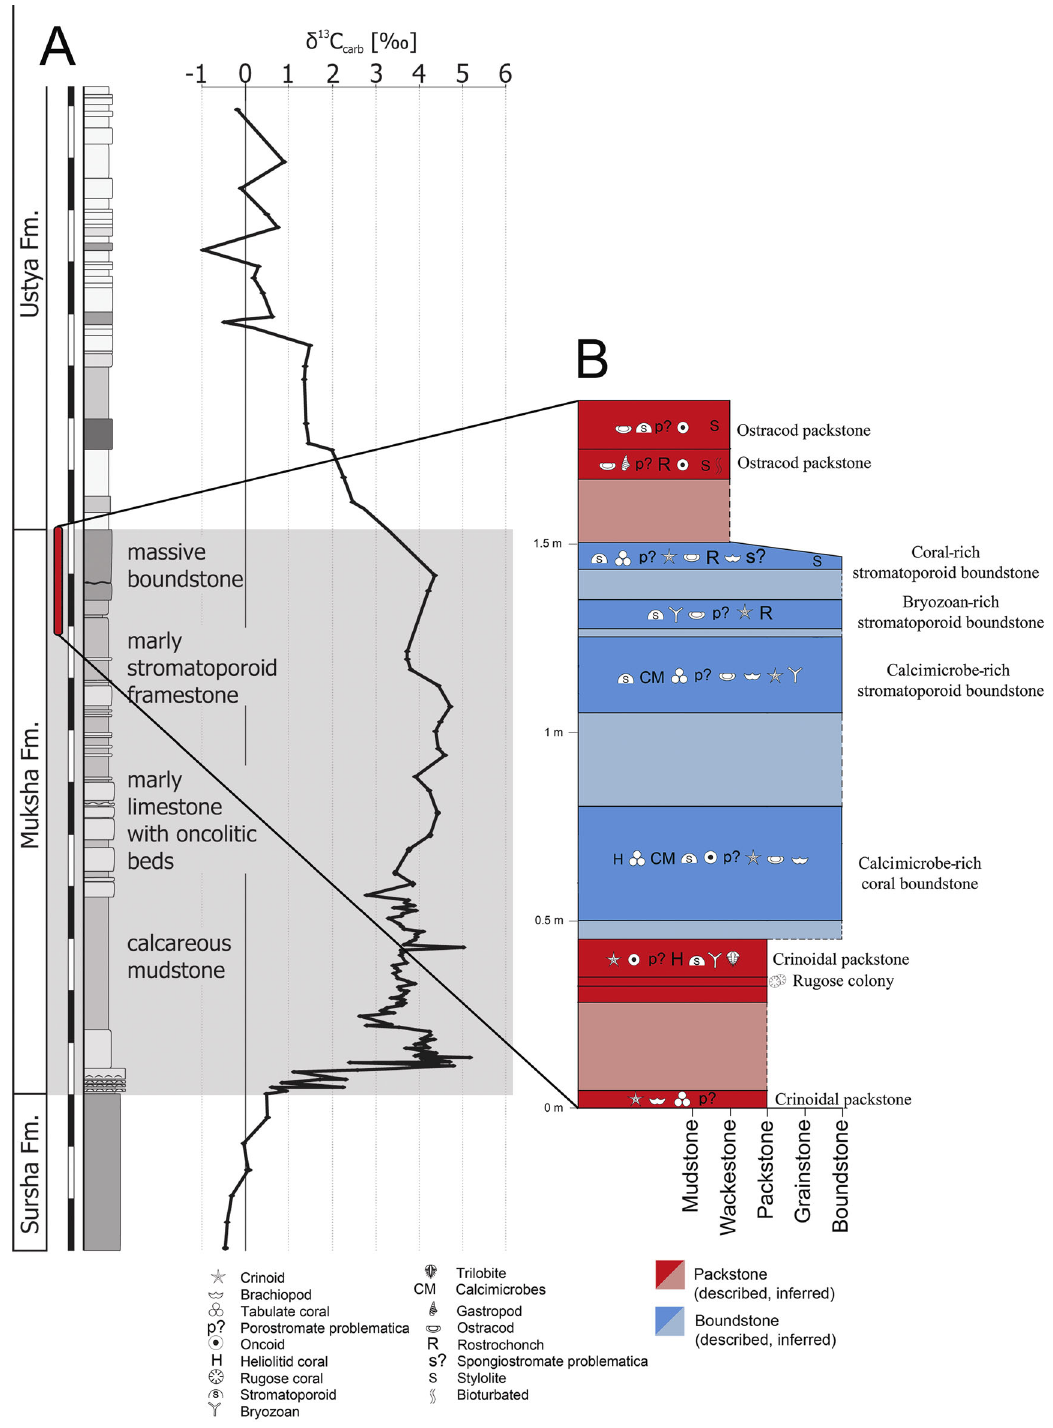
Fig. 2. A , stratigraphic column of the Muksha Formation (highlighted in grey) showing the elevated δ 13 C values (V-PDB) in this interval. The red bar shows an approximate range of the interval in this study (for detailed lithological description see Jarochowska et al. 2014). Scale is in metres. B , lithological column based on the description of polished slabs and thin sections. Inferred sections are due to lack of thin